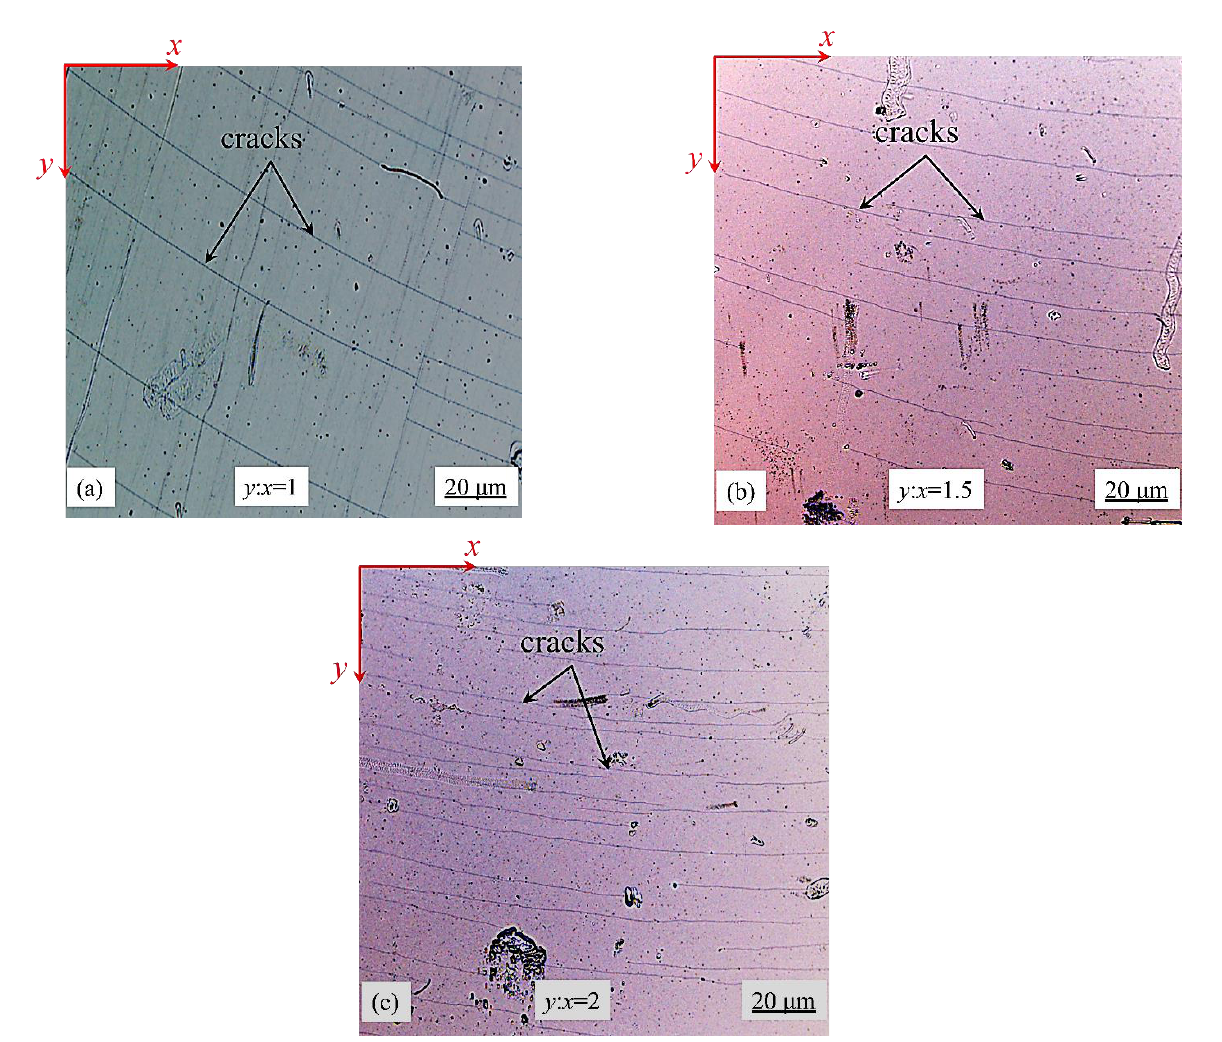
Figure 9. Experimental results under different loading ratios: ( a ) y : x = 1:1, ( b ) y : x = 1.5:1, and ( c ) y : x = 2:1.